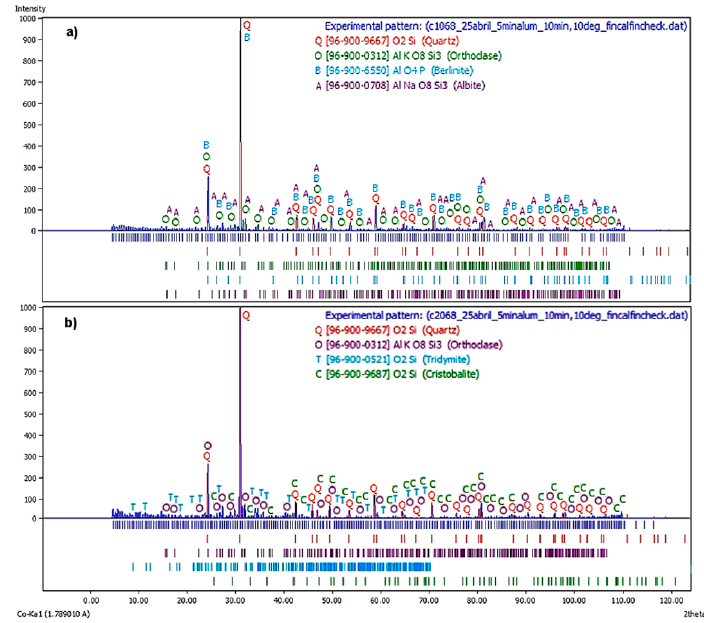
Figure 8. X-ray diffractogram of the material of the “Dos Carlos” dam recovered from the ( a ). First flotation stage at J lT = 0.68 cm/s, and ( b ). Second stage of flotation at J lT = 0.68 cm/s.